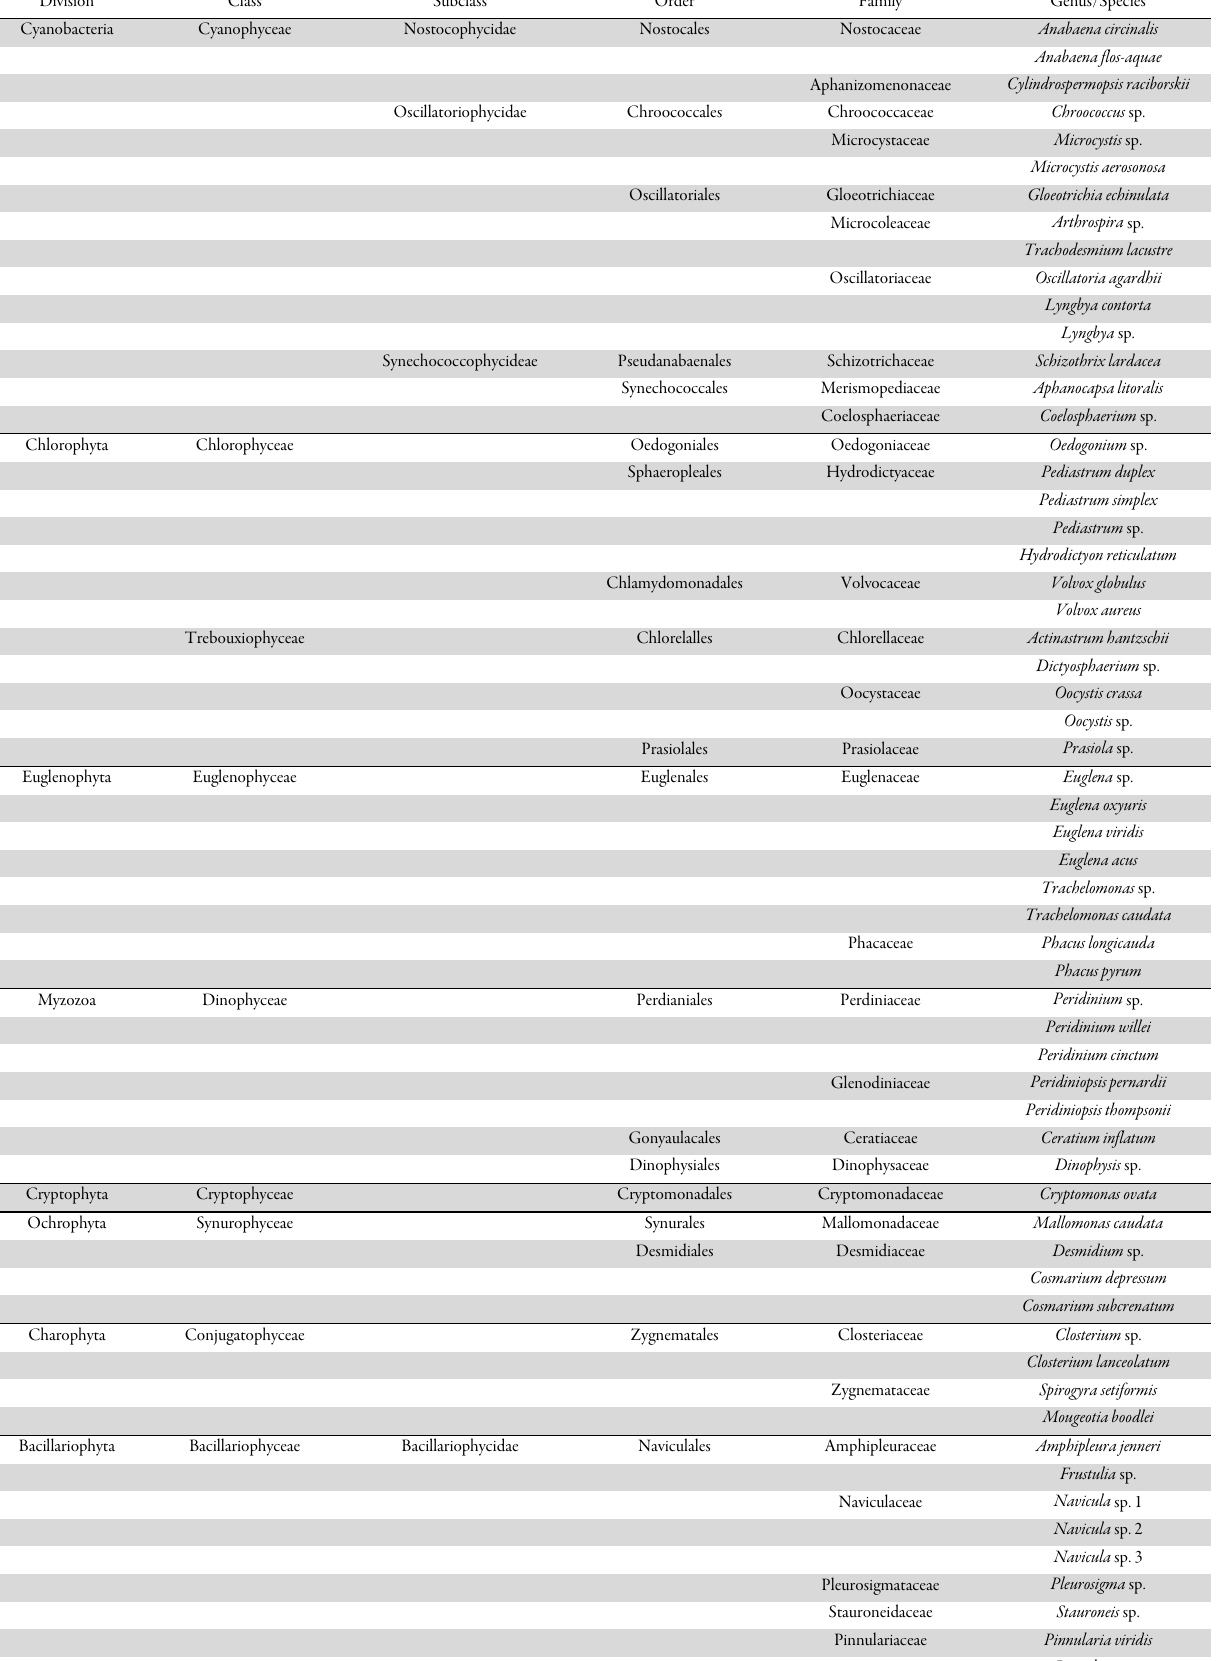
Table 1. Outline classification and taxa composition of the phytoplankton